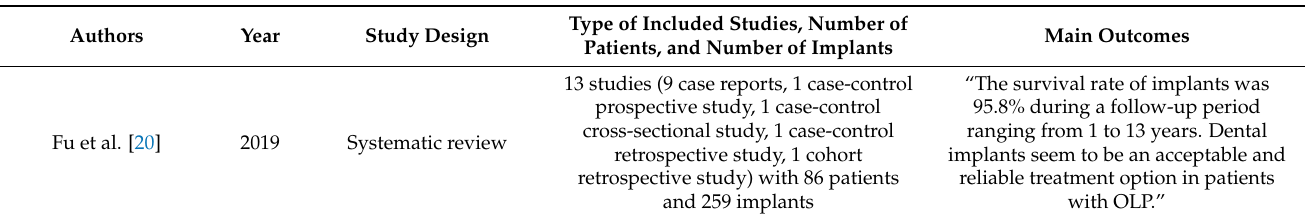
Table 2. Main outcomes of systematic reviews analyzing dental implant treatment in patients with oral lichen